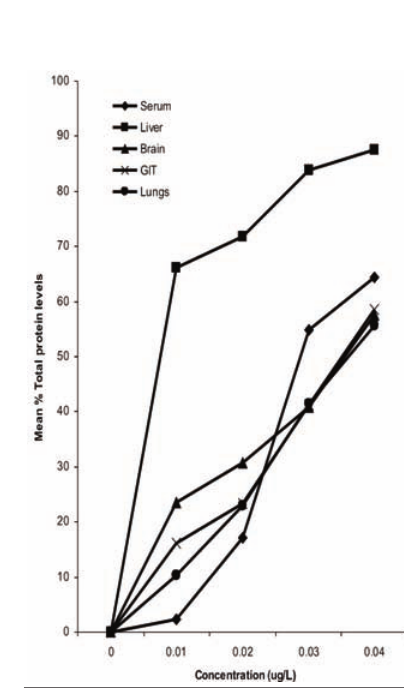
days.Figure 1. Percentage reduction in acetyl- cholinesterase activity in tissues of Bufo regularis exposed to diazinon for 28 days.